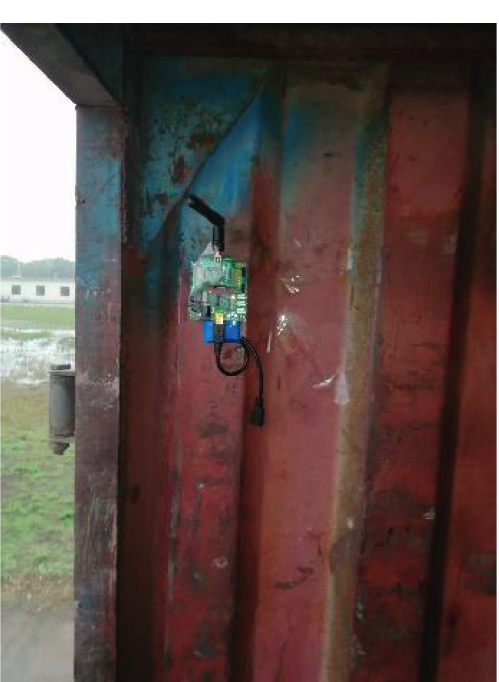
Figure 10: Rear anchor node in the